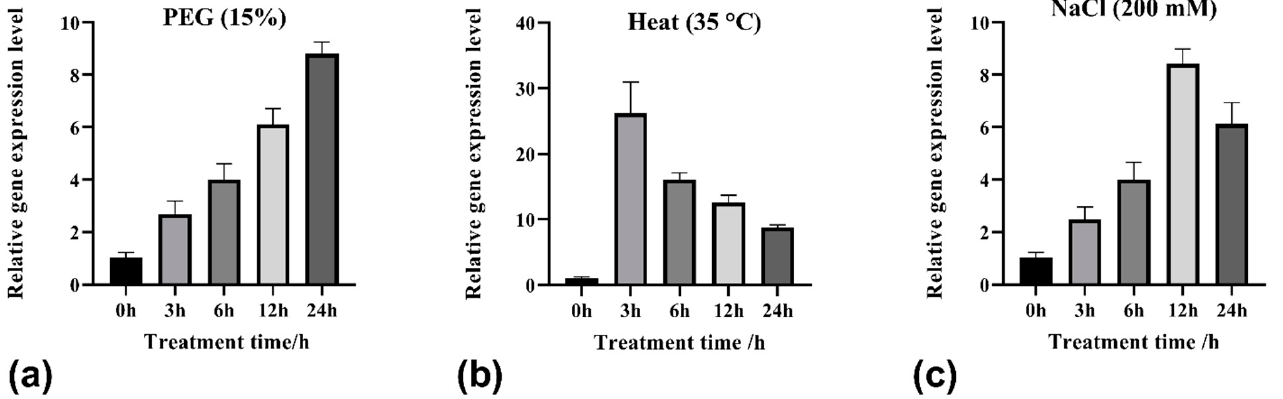
Figure 3. Relative gene expression pattern of TrHSFB2a after drought, heat and salt treatments. ( a – c ) Display expression level of TrHSFB2a under polyethylene glycol 6000 15% w / v , heat (35 ◦ C) and salt (NaCl 200 mM) stresses, respectively, with time course 0, 3, 6, 12, and 24 h after treatments. Error bars represent the standard deviation (SD) of three independent biological